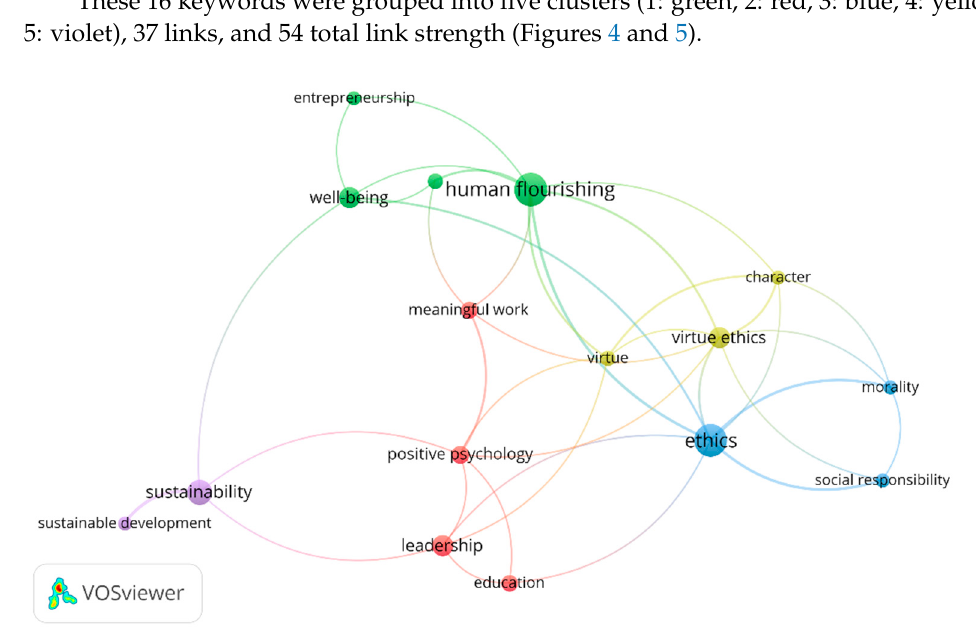
Table 9. HF: Co-citation and total link strength of the top 10 most cited authors.